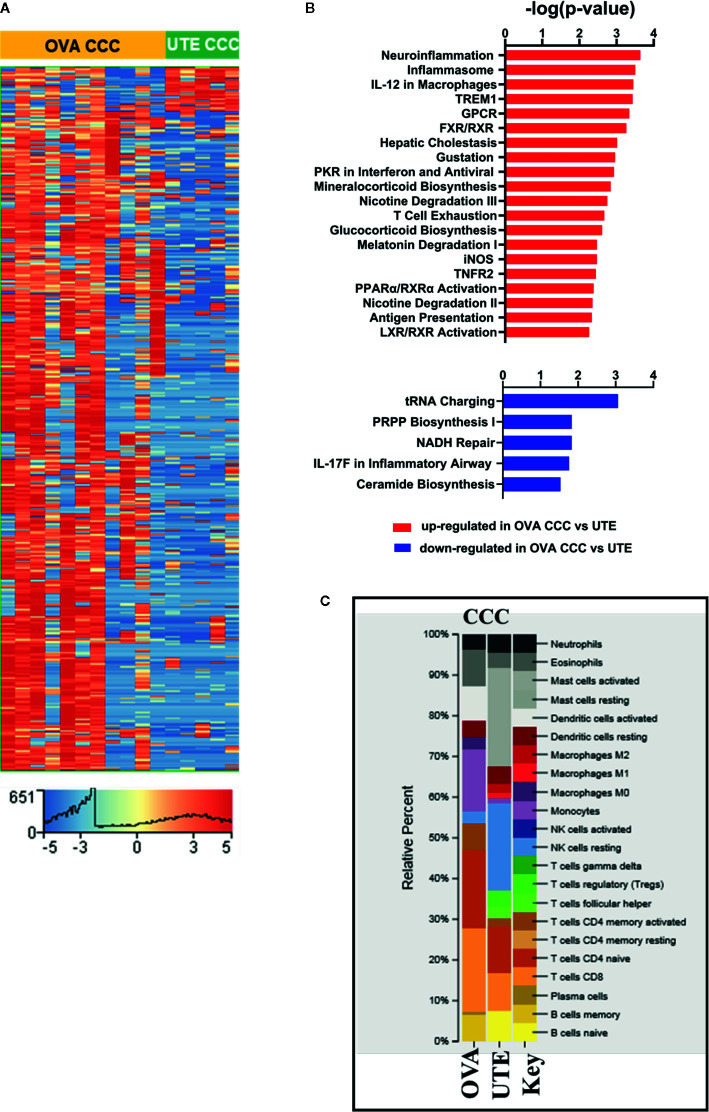
RNA-seq analysis of clear cell ovarian and clear cell uterine cancer. (A) Heat map showing the hierarchical clustering of 1,716 differentially expressed genes (corrected p < 0.05, |FC| ≥10) in clear cell ovarian (n = 11) versus clear cell uterine (n = 5) cancer. (B) Bar diagrams depicting the top 20 significant pathways (p < 0.05) associated with upregulated genes and top five significant pathways (p < 0.05) associated with downregulated genes in OVA CCC as compared to UTE CCC. (C) CIBERSORT analysis of immune cell compositions in clear cell ovarian and uterine carcinomas. The frequency of infiltrated immune cell types was estimated using gene expression profiling data of the two sites. OVA CCC and OVA ovarian clear cell carcinoma; UTE and UTE CCC, uterine clear cell carcinoma.